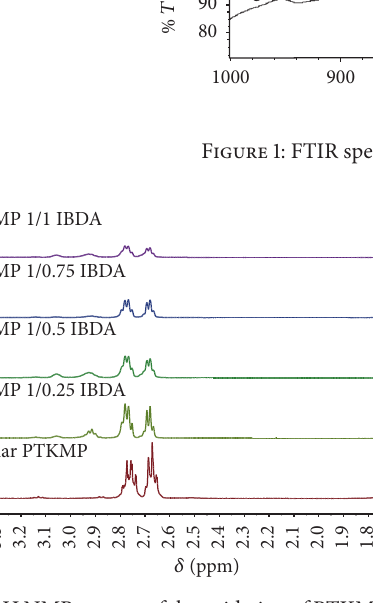
Figure 2: 1 H NMR spectra of the oxidation of PTKMP with varying concentration of IBDA.